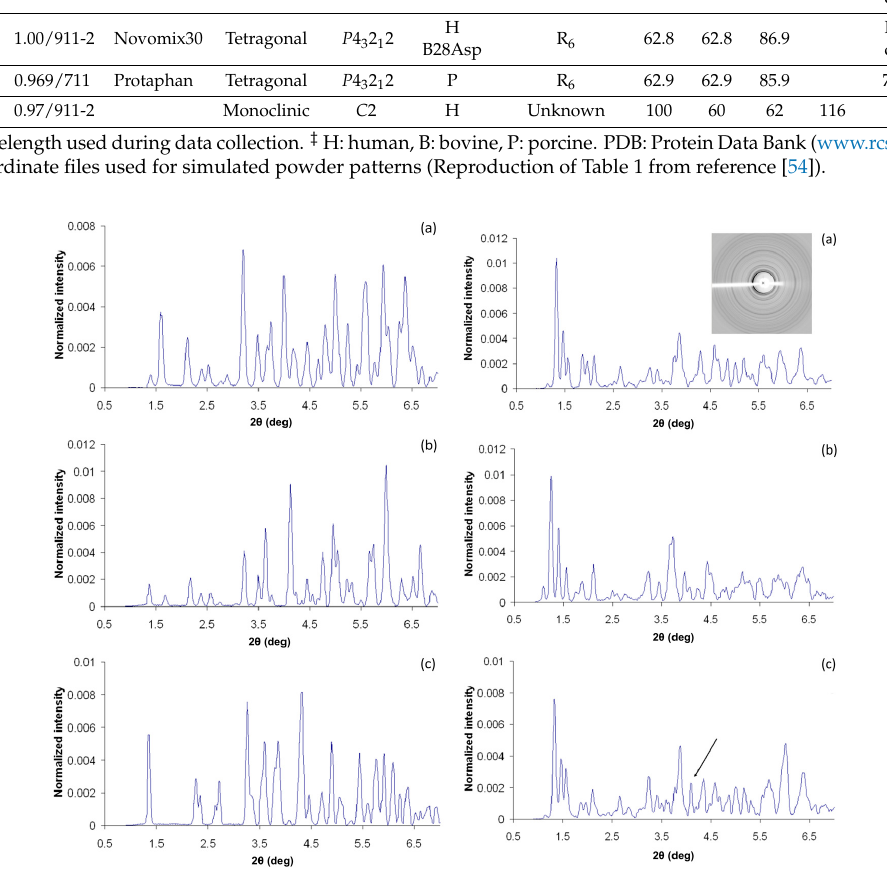
Figure 3. Comparison of experimental diffraction patterns of various crystal types. Left Panel: XRPD patterns (normalized intensities) of crystals D ( a ), E ( b ) and F ( c ), in R 3 space group. Several variations in peak positions are evident in a wide 2 θ range, owing to distinct B-chain conformations (R 6 , T 3 R 3f and T 6 ). Right Panel: XRPD patterns obtained from I ( a ), J ( b ), and K ( c ) crystals in P 4 3 2 1 2 space group. I and K patterns are similar, apart from an extra peak found in the K dataset (indicated with an arrow), while larger unit-cell parameters of J crystals are clearly depicted as numerous shifts in diffraction peaks positions (Reproduction of Figures 2 and 3 from reference [54]. Reproduced with permission of the International Union of